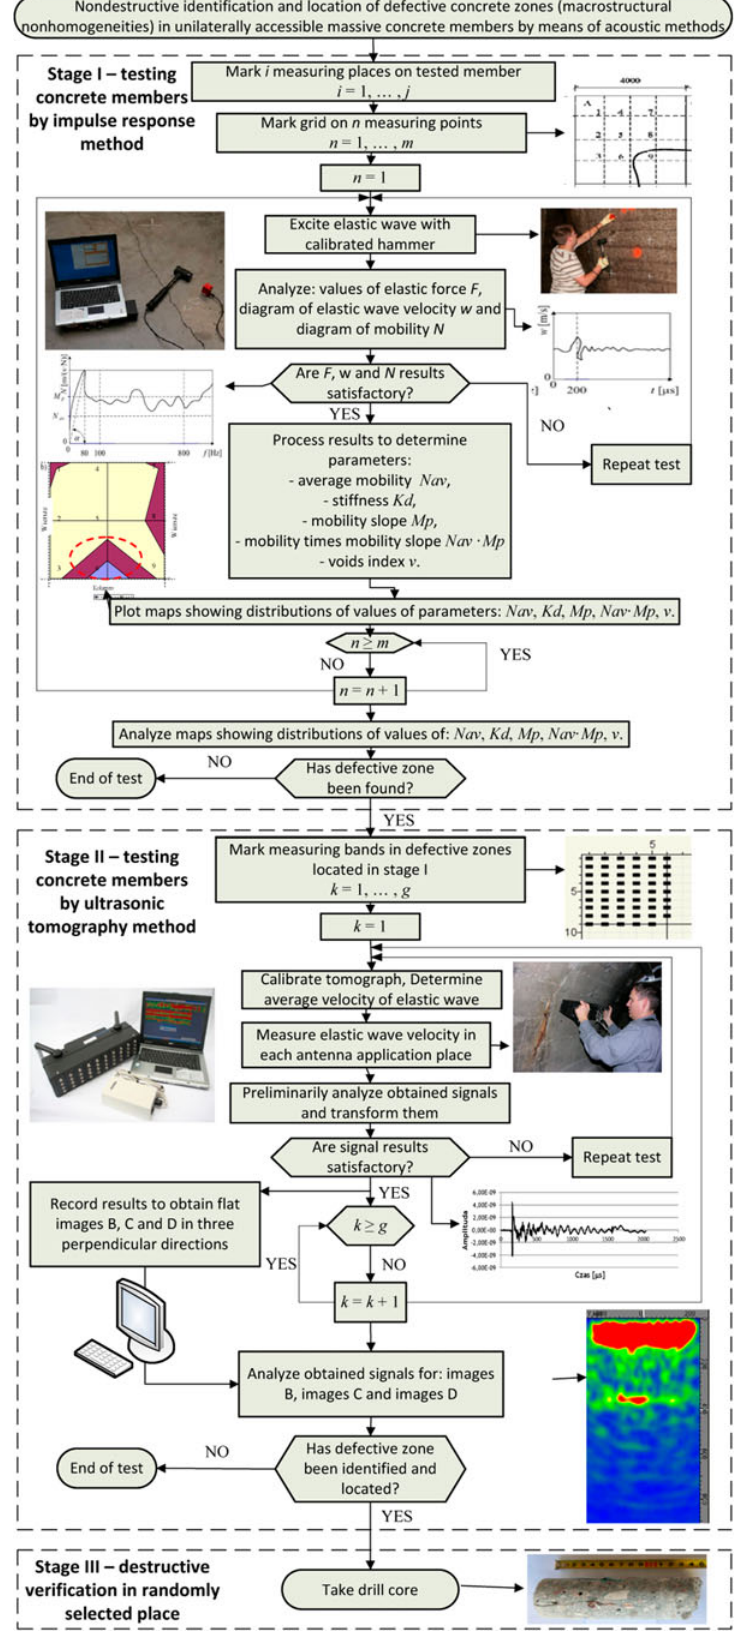
Fig. 3. Flow chart illustrating methodology of nondestructive identification and location of defective zones in unilaterally accessible massive concrete members by means of impulse response and ultrasonic tomography